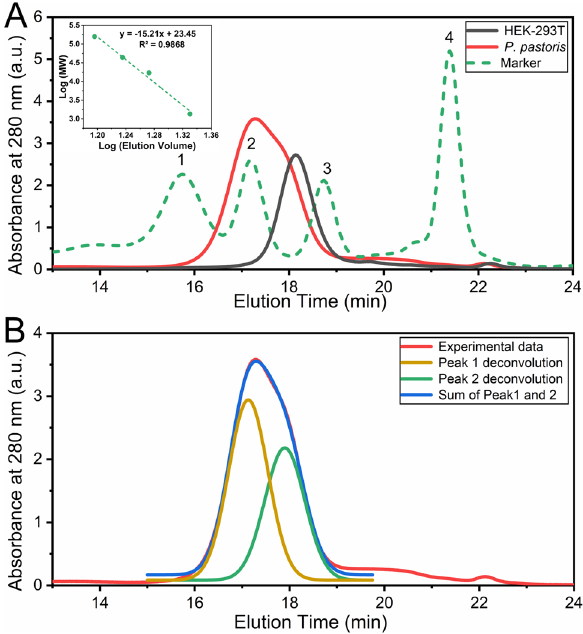
Figure 6. Hydrodynamic behavior of RBD. ( A ) SEC-HPLC of RBD produced in P. pastoris (red), HEK-293T (black) and molecular weight markers (dashed green line). This analysis was carried out by injecting 50 μL protein aliquots (0.70 and 0.75 mg/mL for RBD produced in P. pastoris and HEK-293T, respectively) in 20 mM Tris–HCl, 100 mM NaCl, pH 7.0 buffer. The inset shows the correlation between molecular weight and elution volume obtained from the molecular weight markers: (1) gammaglobulin (158 kDa), (2) ovoalbumin (44 kDa), (3) myoglobin (17 kDa), and (4) vitamin B12 (1350 Da). (B) Deconvolution analysis of the chromatographic profile from RBD from P. pastoris . The experimental profile (red), deconvolution of the peak in two different gaussian curves (green and yellow) and the sum of the deconvoluted peaks (blue) are